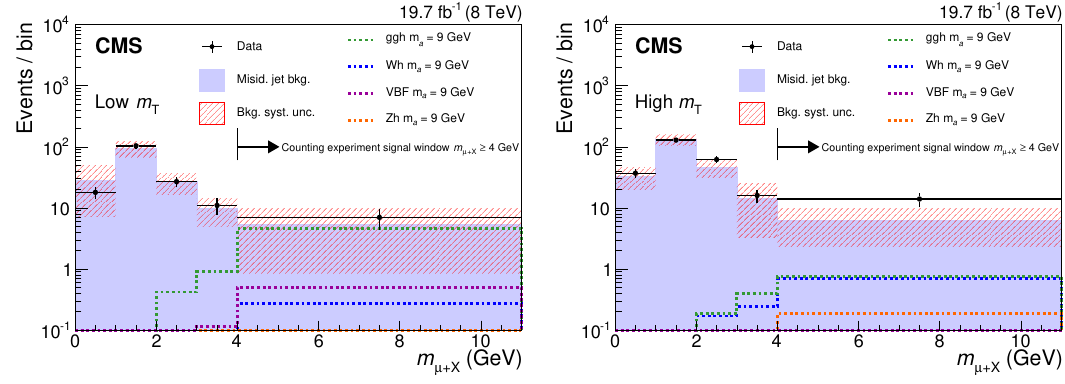
Figure 1 . Comparison, for the h ! aa ! 4 (cid:28) search, of m (cid:22) +X distributions for data (black markers) and the misidenti(cid:12)ed jet background estimate (solid histogram) in the low- m T (left) and high- m T (right) bins. Predicted signal distributions (dotted lines) for each of the four Higgs boson production mechanisms are also shown; the distributions are normalized to an integrated luminosity of the data sample of 19.7 fb (cid:0) 1 , assuming SM Higgs boson production cross sections and B (h ! aa) B 2 (a ! (cid:28) + (cid:28) (cid:0) ) = 0 : 1. The last bin on the right contains all the events